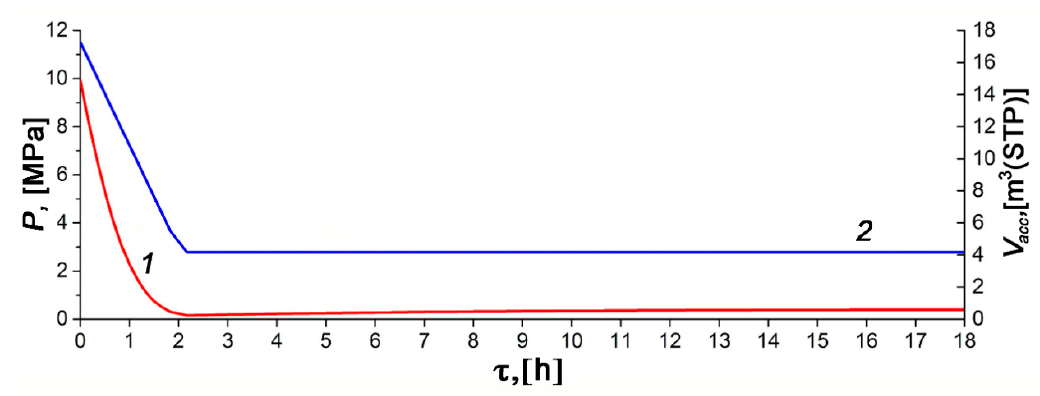
Figure 13. Temporal variations of pressure (1) and the amount of gas accumulated in the adsorber (2) during the discharge cycle calculated for the thermally insulated conditions.